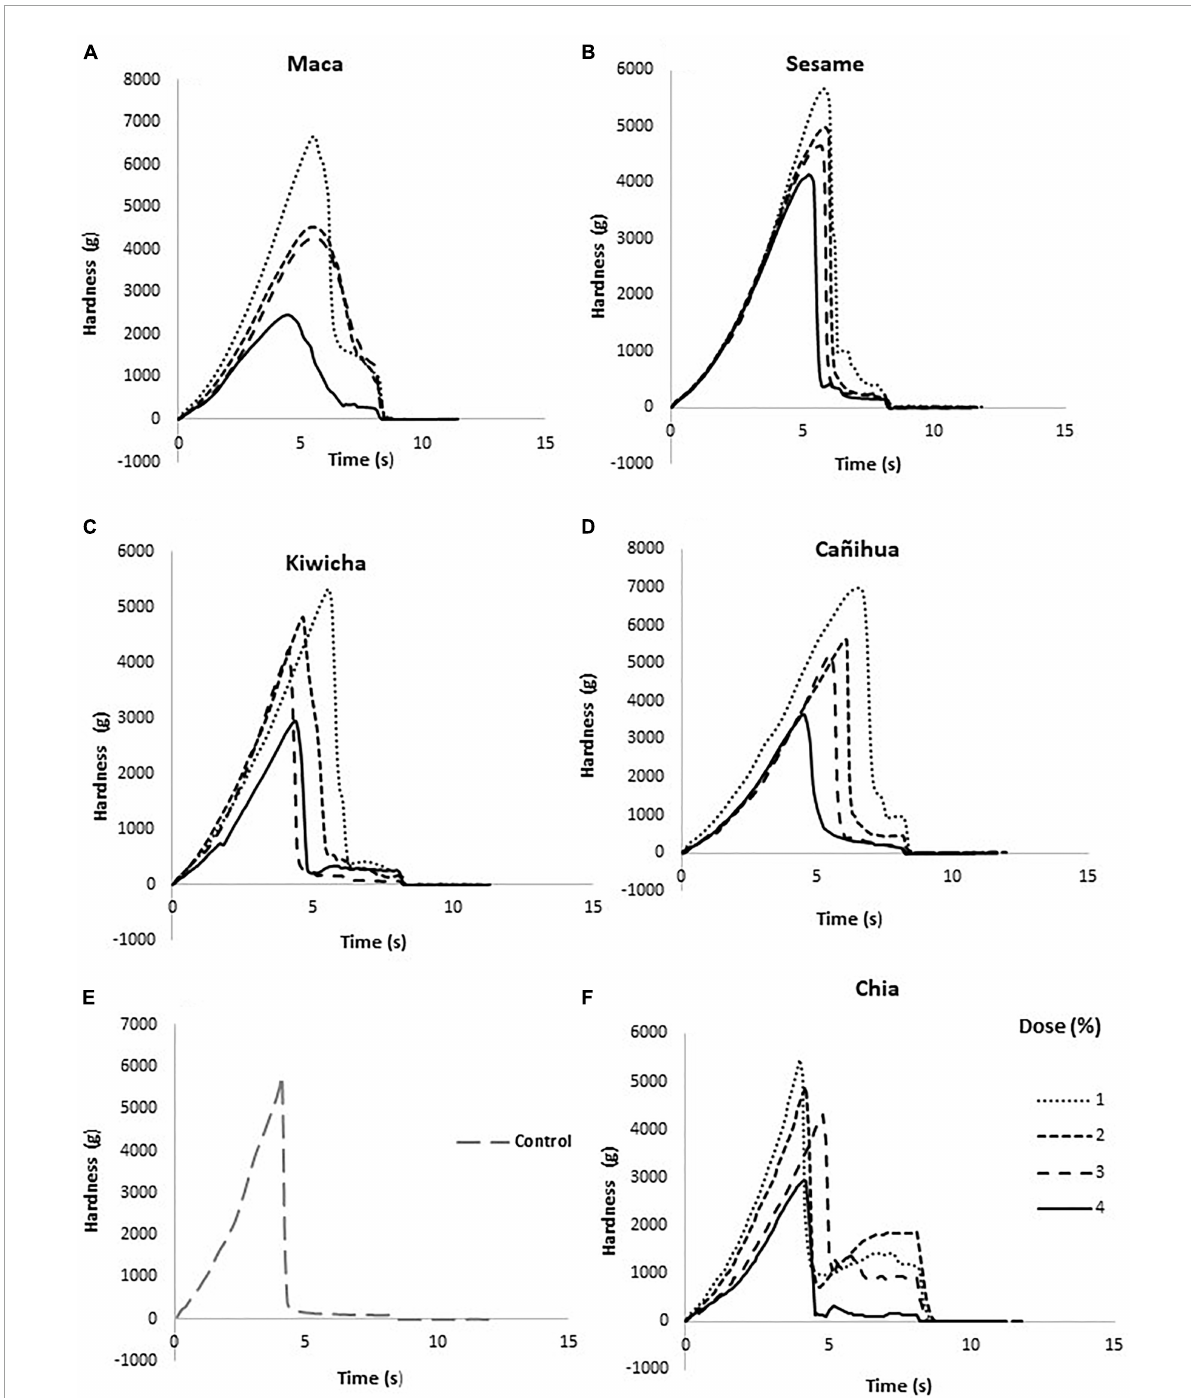
FIGURE3 Typical texture curves of dark chocolates with the addition of flours. (A) Maca, (B) ajonjolí, (C) kiwicha, (D) cañihua, (E) chia, and (F) with no